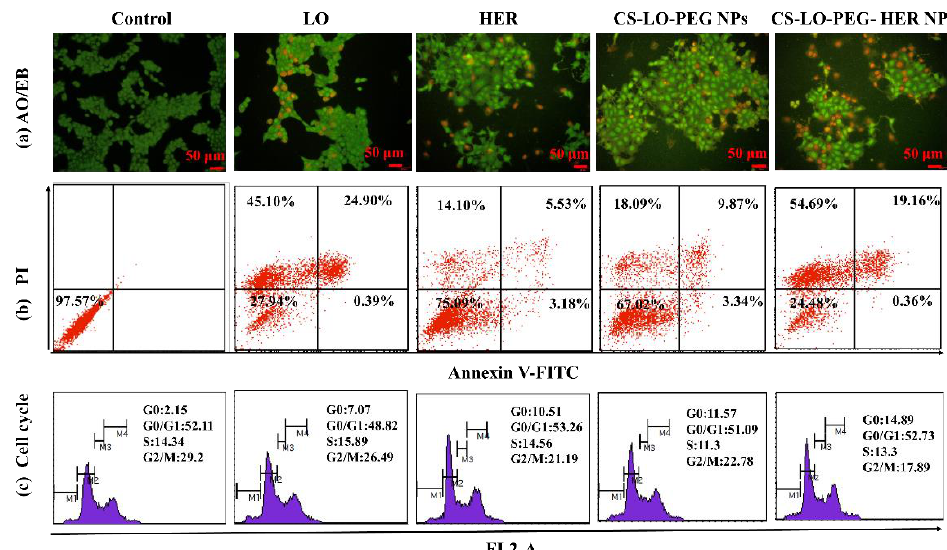
Figure 5. Effect of L-lysine α -oxidase, herceptin, and different nanoparticles treatment on apoptosis stages of BT474 cell line observed by AO/EB staining ( a ), FITC and annexin V staining based flow cytometry assay ( b ) and cell cycle stages by PI staining ( c ). Where CS is chitosan, LO is L-lysine α -oxidase, PEG is polyethylene glycol 600, HER is herceptin (Trastuzumab).